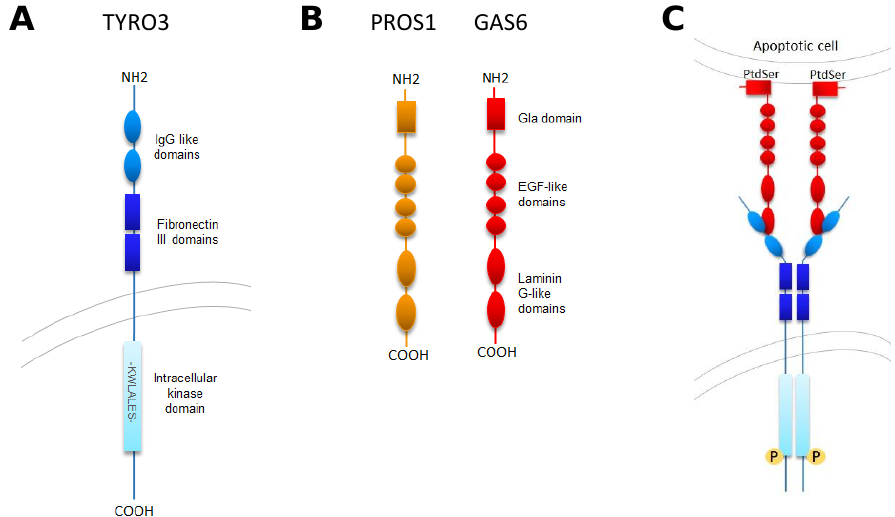
Figure 1. TYRO3 Structure and Activation. ( A ) TYRO3 is a 890 amino acid transmembrane protein